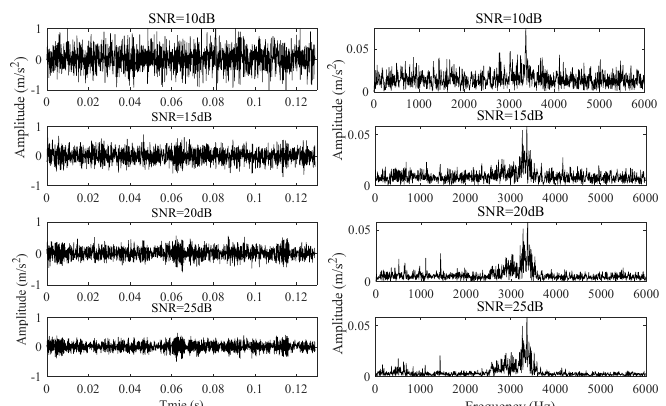
Figure 25. The time ‐ domain and frequency ‐ domain waveforms of four rolling element signals with Figure 25. The time-domain and frequency-domain waveforms of four rolling element signals with different noise levels. different noise